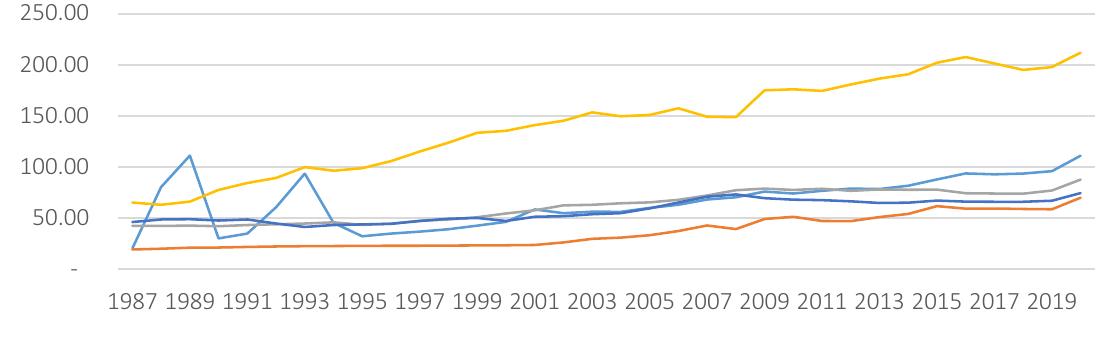
Figure 1. Broad money supply (% of GDP) trends for